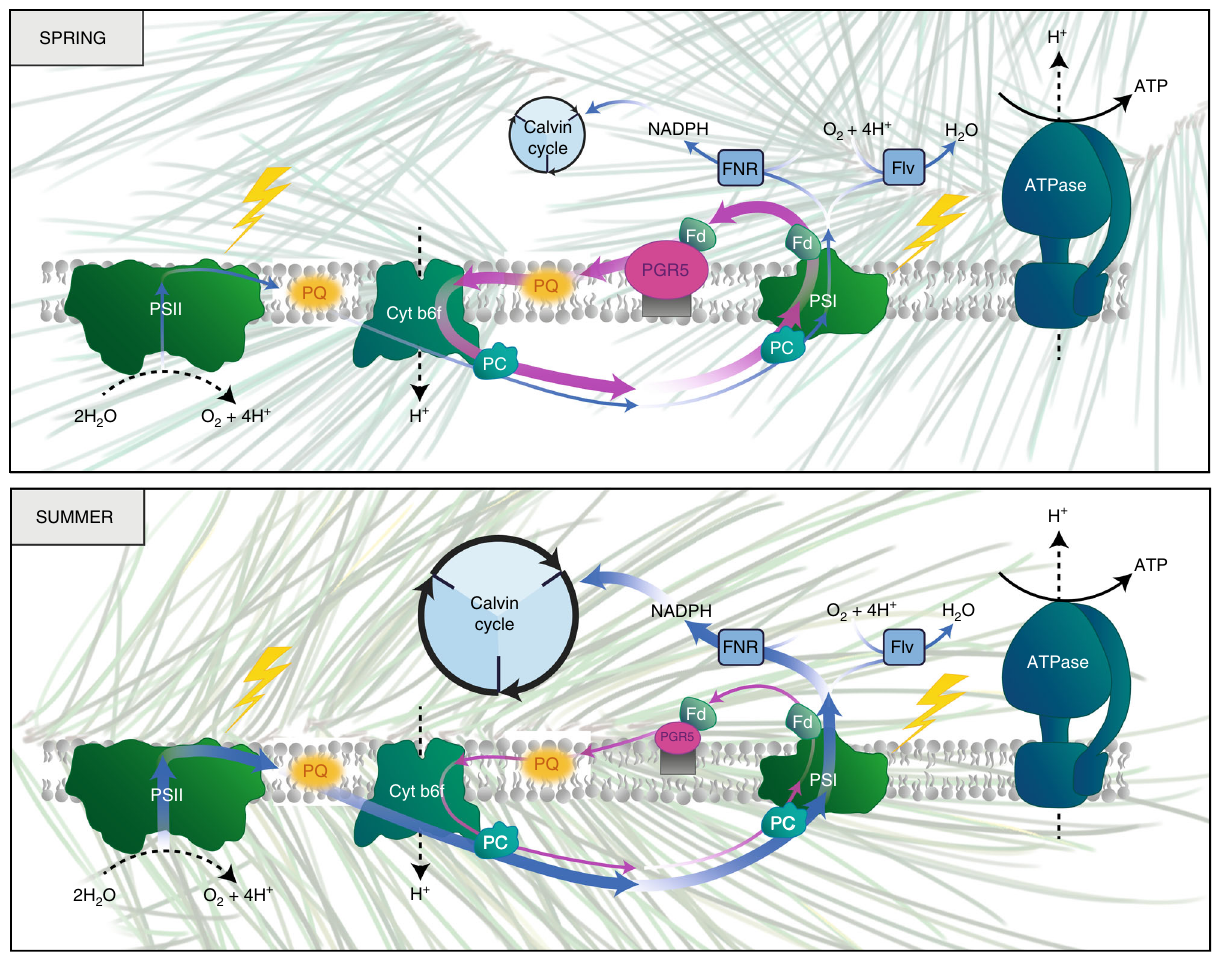
Fig. 6 Scots pine has evolved the superior strategy for photosynthesis in the North. Scots pine demonstrated a clear modulation of electron sink capacity over the year where the capacity for CO 2 assimilation was downregulated during winter and then gradually upregulated during spring in response to warming. To compensate for the reduced CO 2 assimilation capacity during the critical late winter – early spring months, Scots pine induces PGR5-dependent CET activity to provide an alternative electron sink to protect the photosystems from photodamage at a time when CO 2 assimilation capacity is limited. PC plastocyanin. Blue arrows represent linear electron transport, magenta arrow represents alternative electron